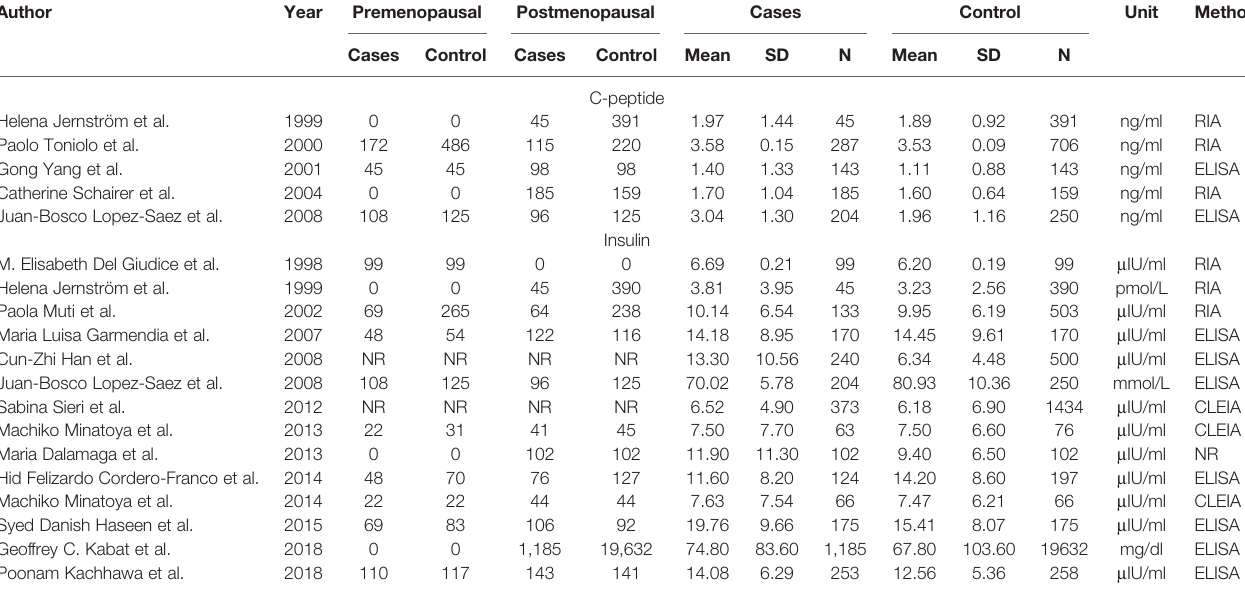
TABLE 2 | The levels of serum insulin or C-peptide in each primary study.